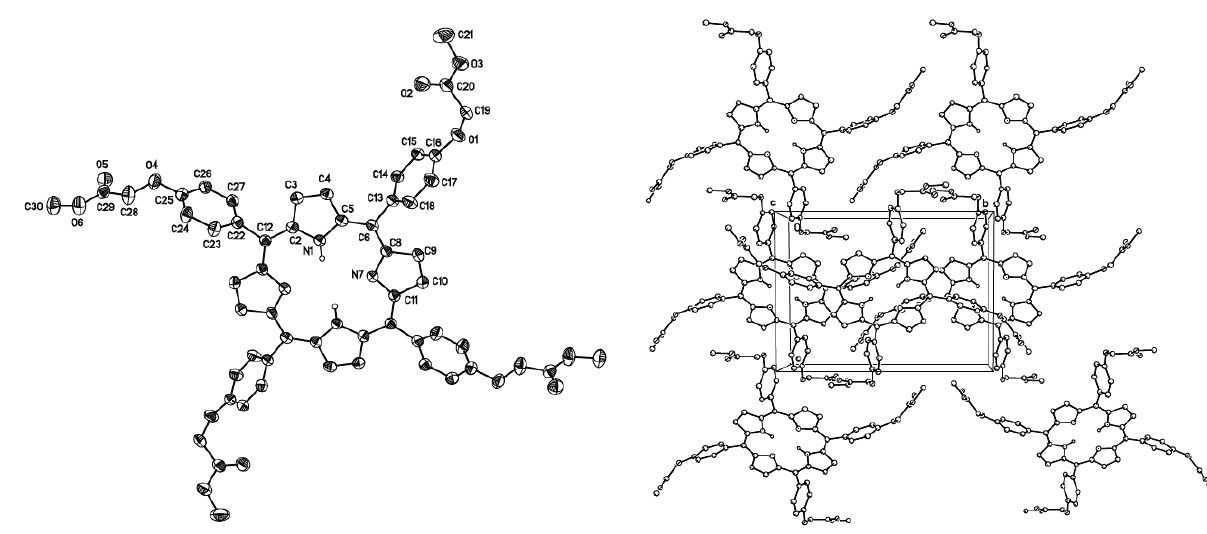
Figure 4. Crystal structure and crystal-packing of dendrimer 2 .